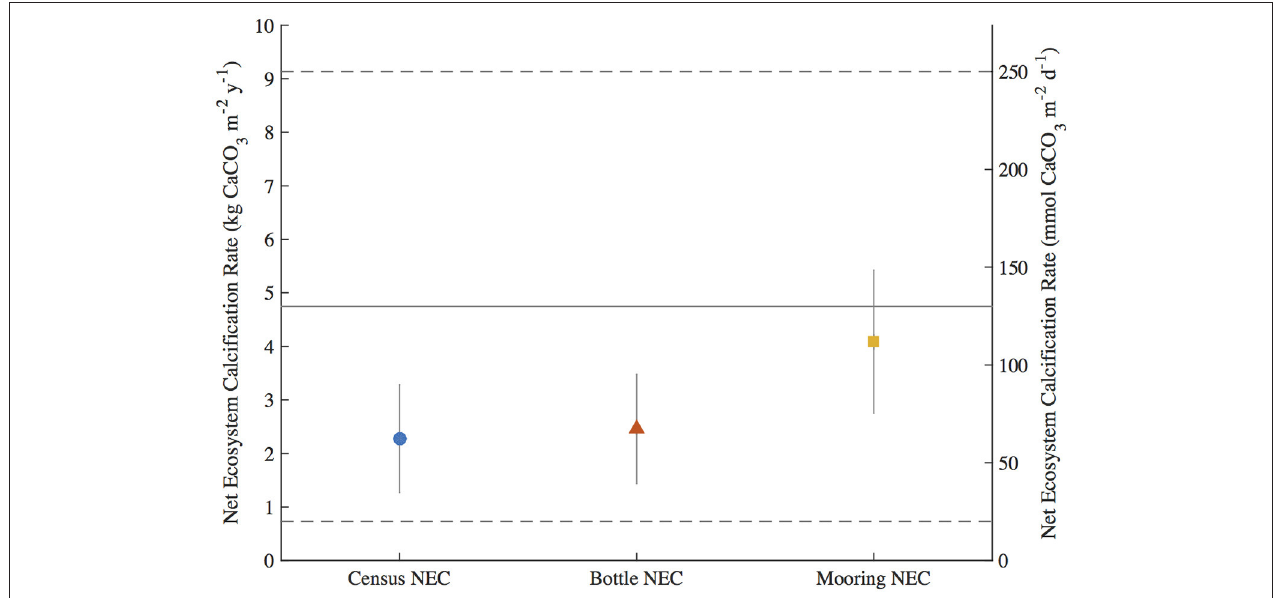
FIGURE 6 | Integrated Net Ecosystem Calcification (NEC) ( ± uncertainty) during the first mooring deployment from 2011.2 to 2012.1 for the census NEC, bottle NEC, and mooring NEC. The solid gray line and dashed gray lines represent the mean and range of NEC, respectively, for reef flats globally from Atkinson